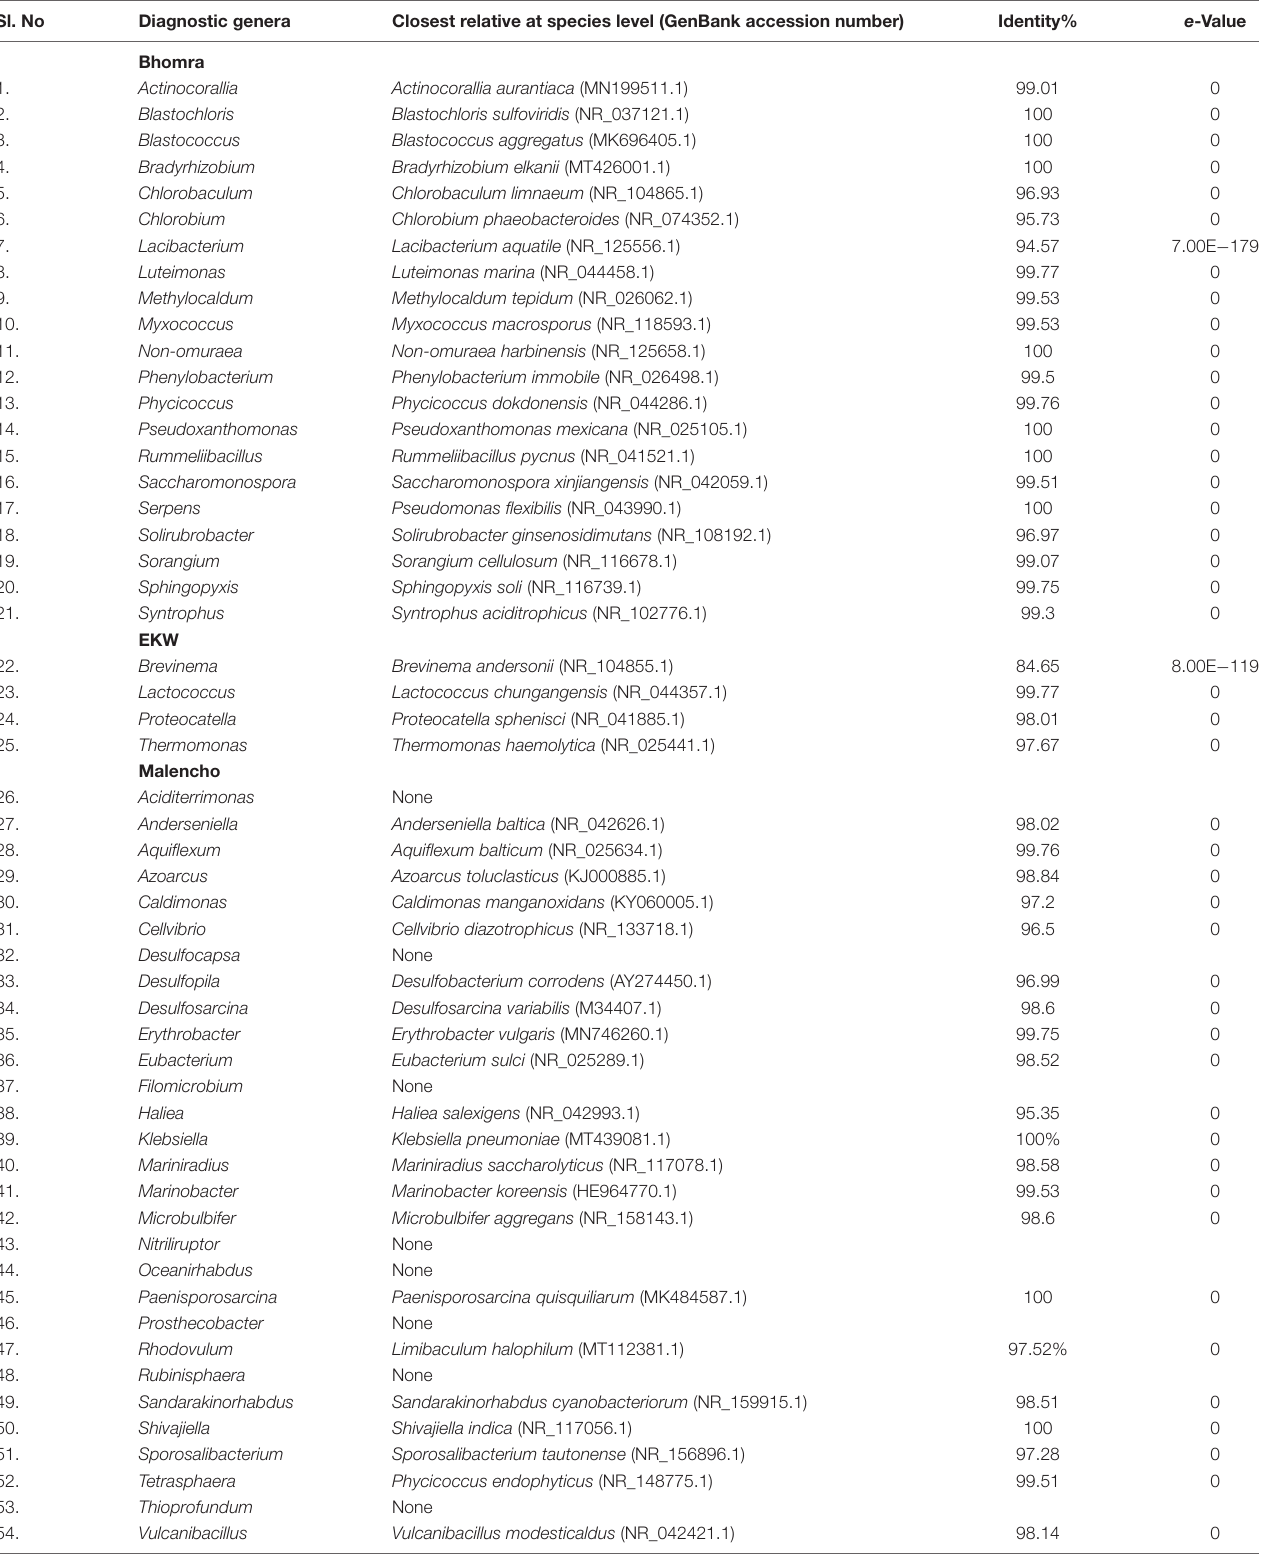
TABLE 3 | Diagnostic genera and their closest relative (at species